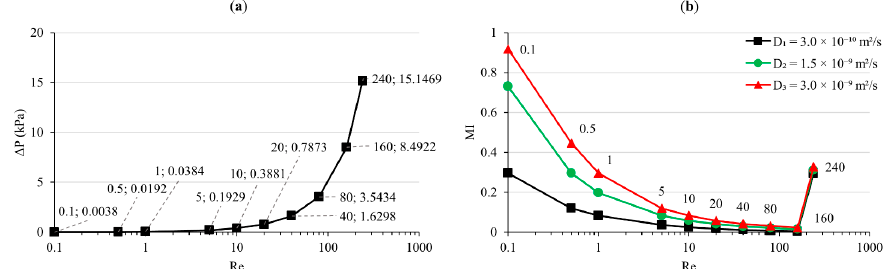
Figure 5. ( a ) Pressure drop vs. Re number in CT micromixer. The numbers before and after the semicolons represent Re number and pressure drop values respectively; ( b ) MI vs. Re number for different molecular diffusion coefficients in CT-FI-RI.